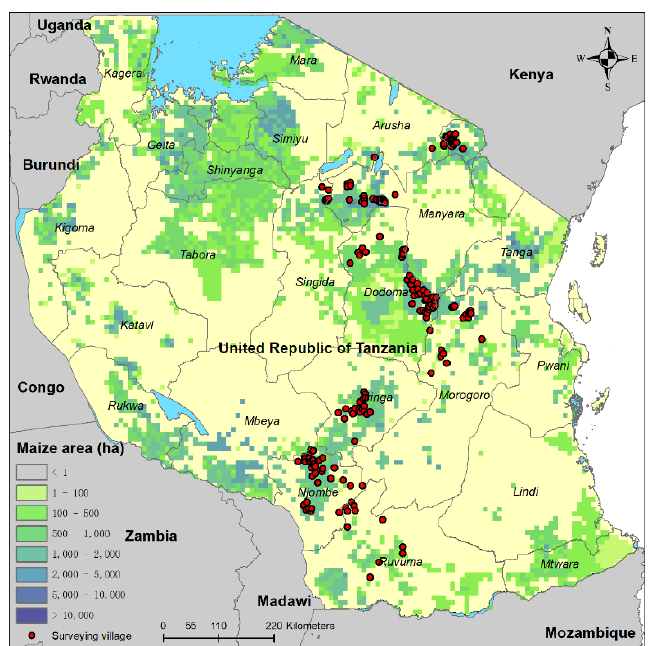
Figure 5. Study area and villages participating in the World Food Program Patient (WFP) Procurement Platform (PPP) 2016. Participating villages are indicated as red circles. Background image: maize area in 2000.